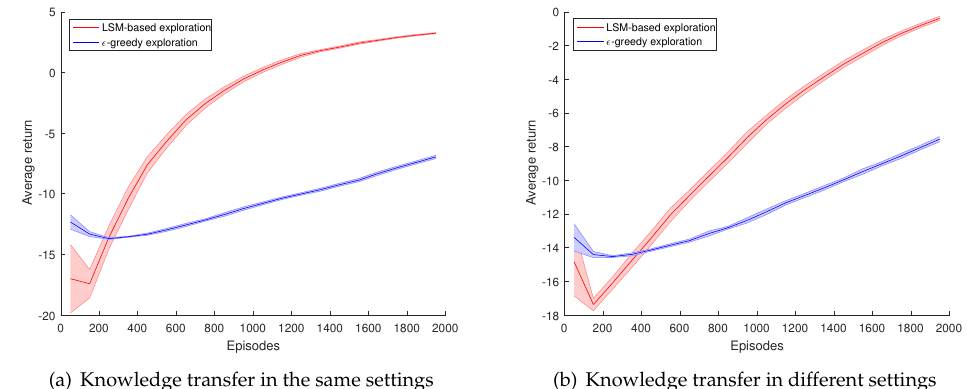
Figure 3. The learning curves of LSM-based exploration strategy and (cid:101) -greedy exploration strategy on the maze navigation problem. The curves are smoothed with a window of 100 episodes with an error bar at every 100 episodes.